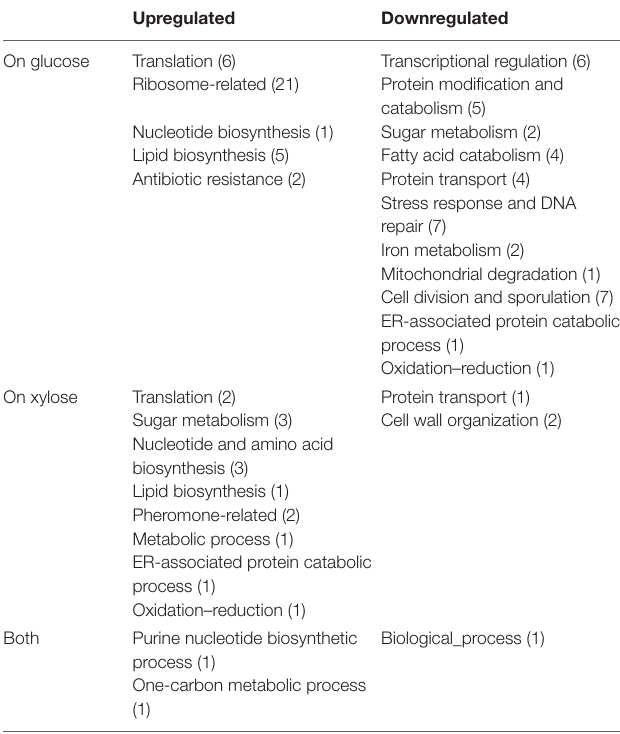
TABLE 4 | Gene set enrichment analysis (GSEA) using GO biological process on DE genes by (cid:49) gcr2 .